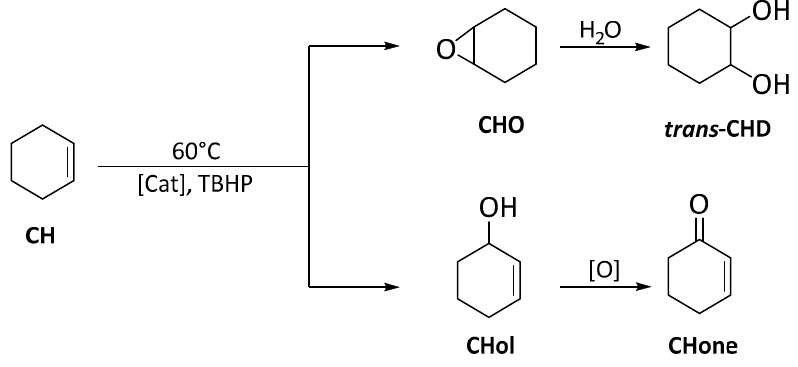
Table 4. Relevant data for the catalyzed (ep)oxidation of cyclohexene 1.